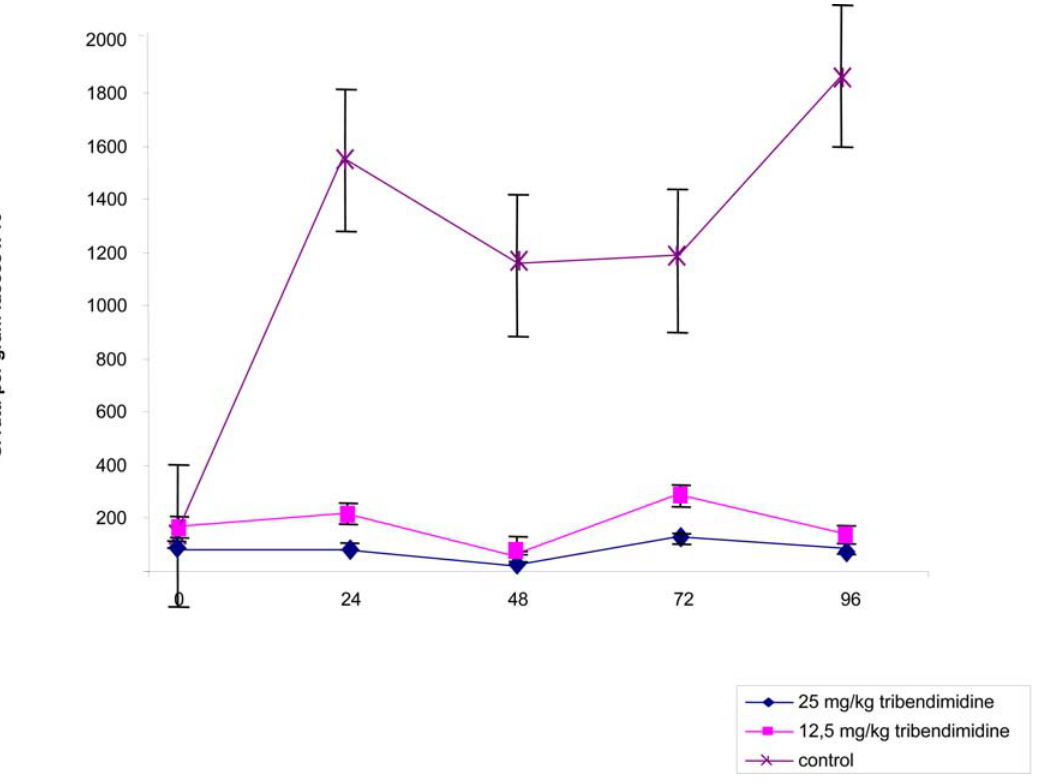
Table 2. Effect of ivermectin and tribendimidine (different doses) against adult S. ratti harbored in rats.